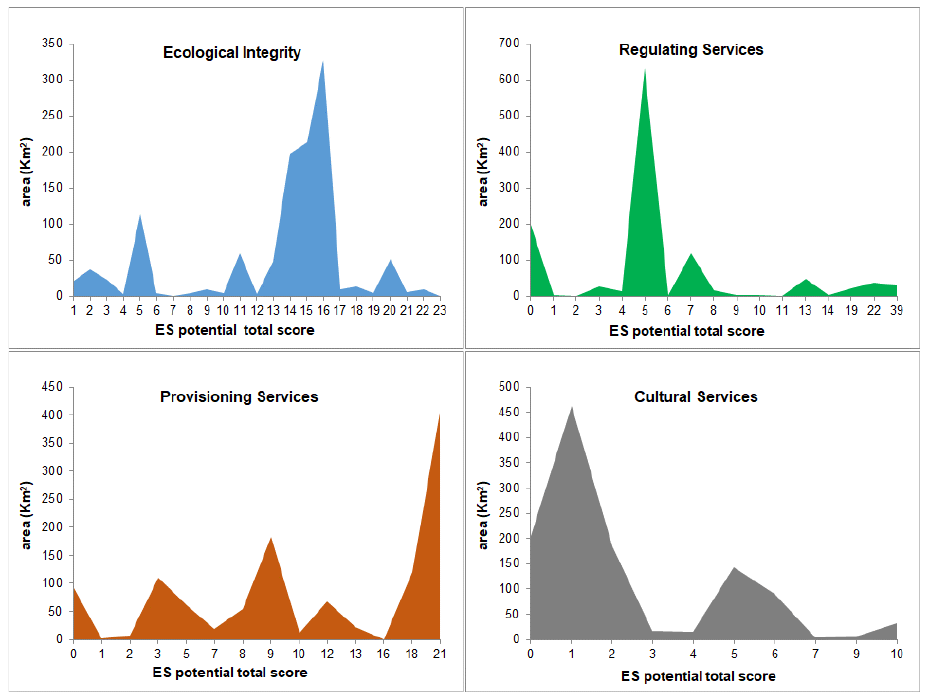
Figure 6. Potential score of the four designated ecosystem services (ES) categories (ecological integ- rity, regulating, provisioning, and cultural services) and respective area of the Greek Natura 2000 sites invaded by Solanum elaeagnifolium .